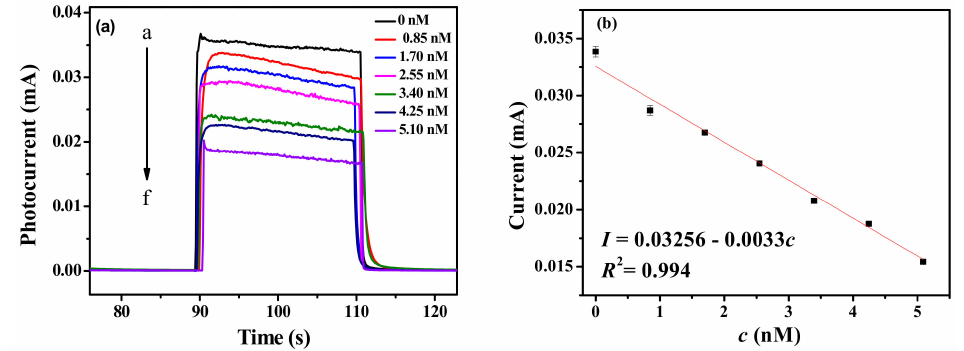
Figure 5. ( a ) Photocurrents of the as-prepared PEC biosensor based on CSZFRs with different concentrations of NV RNA; ( b ) Linear relationship graph.